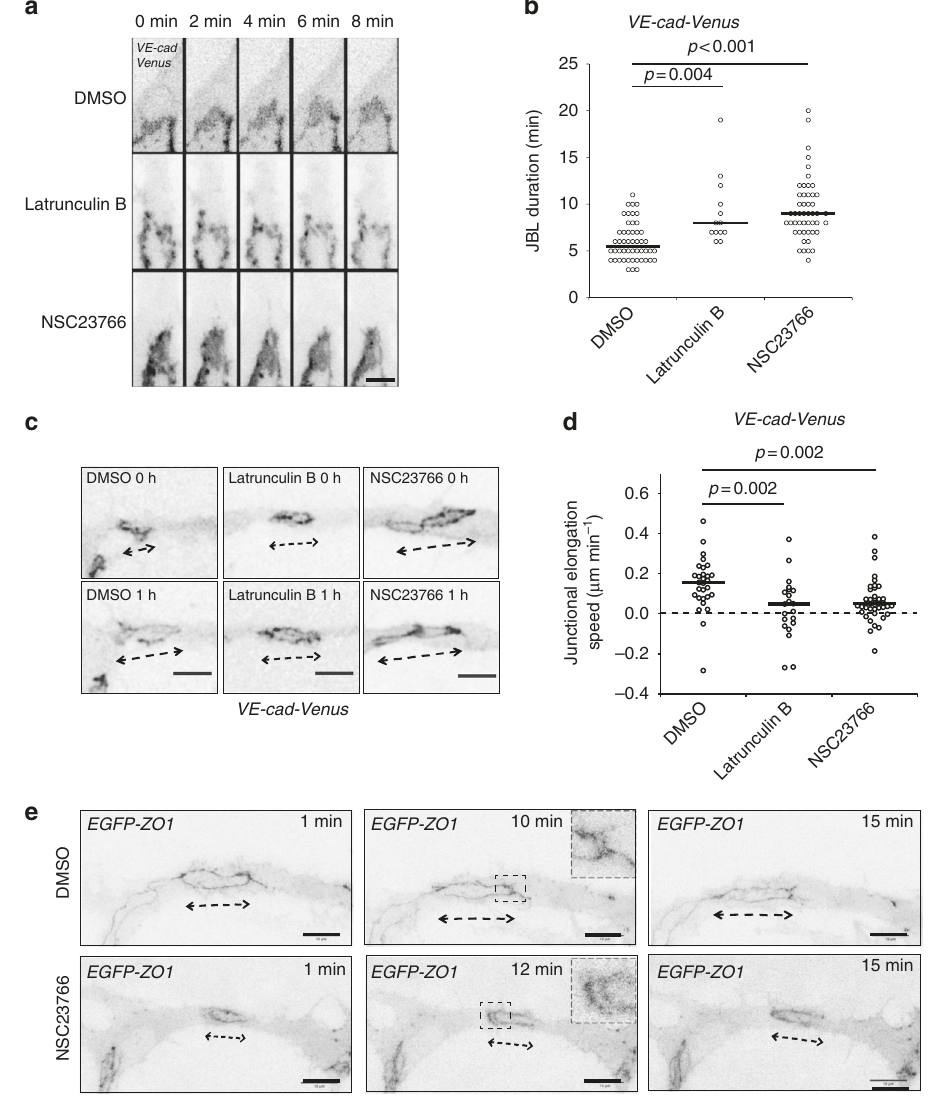
Fig. 6 Junction elongation and JBL formation are functionally linked. a Still images from a movie of an VE-cad-Venus expressing embryo Tg (BAC( cdh5:cdh5- ts )) during anastomosis in the DLAV (around 32 hpf), in the presence of DMSO (1%), Latrunculin B (150 ng ml − 1 ) or NSC23766 (900 µ M). b Scatter plot quantitation of the duration of the JBL. DMSO, n = 50 (6 movies); Latrunculin B, n = 13 (5 movies); NSC23766, n = 49 (10 movies); black lines show median values. Non-parametric Kruskal – Wallis statistical test was used. c Confocal images of a Tg(BAC(cdh5:cdh5-ts)) embryo during junctional elongation after DLAV anastomosis. Top panels t = 0 and bottom panels after 1 h incubation. d Quanti fi cation of the junctional elongation velocity in the presence of different chemicals using Tg(BAC(cdh5:cdh5-ts)) embryos. DMSO (1%), n = 29 junctions (11 embryos); Latrunculin B (150 ng ml − 1 ), n = 21 (6 embryos); NSC23766 (300 µ M), n = 41 (11 embryos). Dotted line indicated no movement observed, black lines are medians. Non-parametric Kruskal –